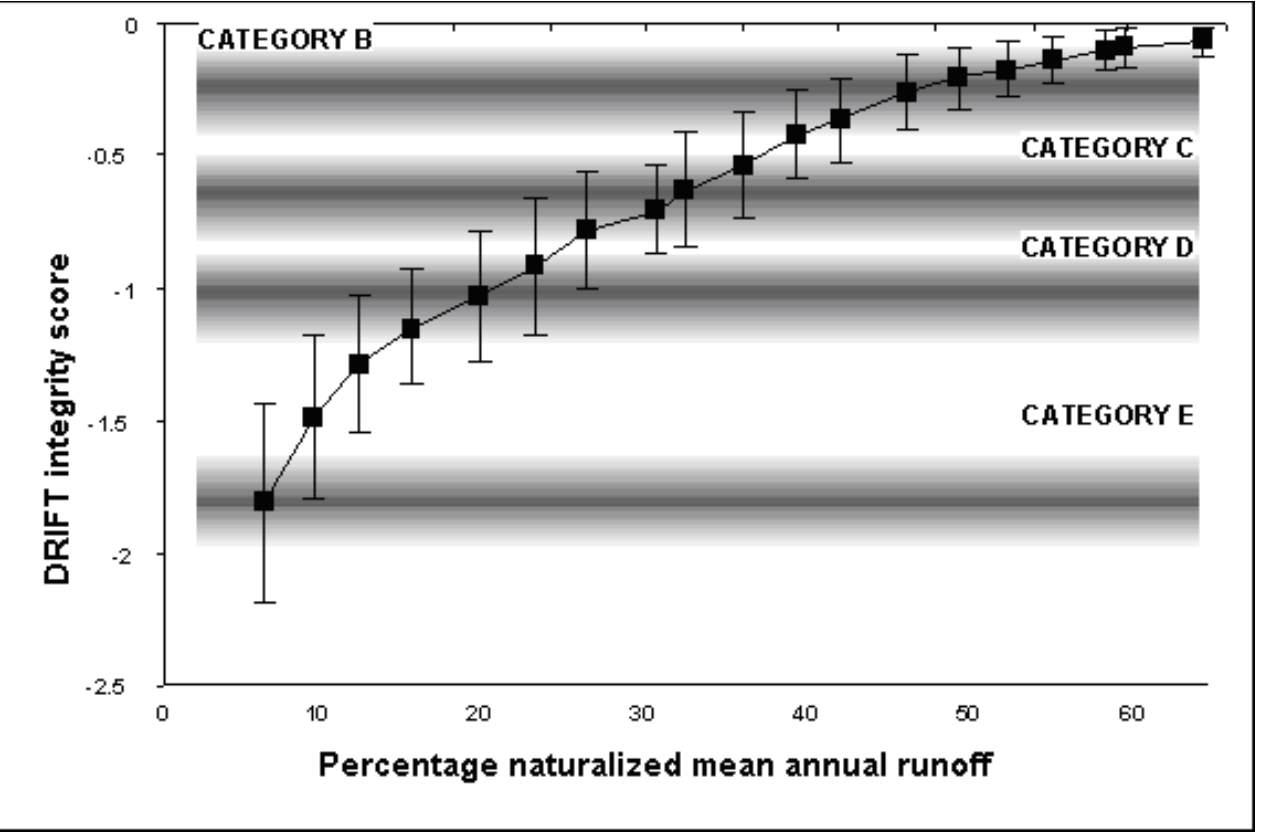
Fig. 3 . Plot of declining ecosystem integrity with loss of flow volume for a site in the Molenaars River created using DRIFT-CATEGORY and with the integrity score based on the averaged severity ratings of change. The river is presently a Category B river, starting point at 0 on the integrity score axis, and is predicted to decline through Categories C, D, and E at the flow volumes shown. The categories are explained in Table